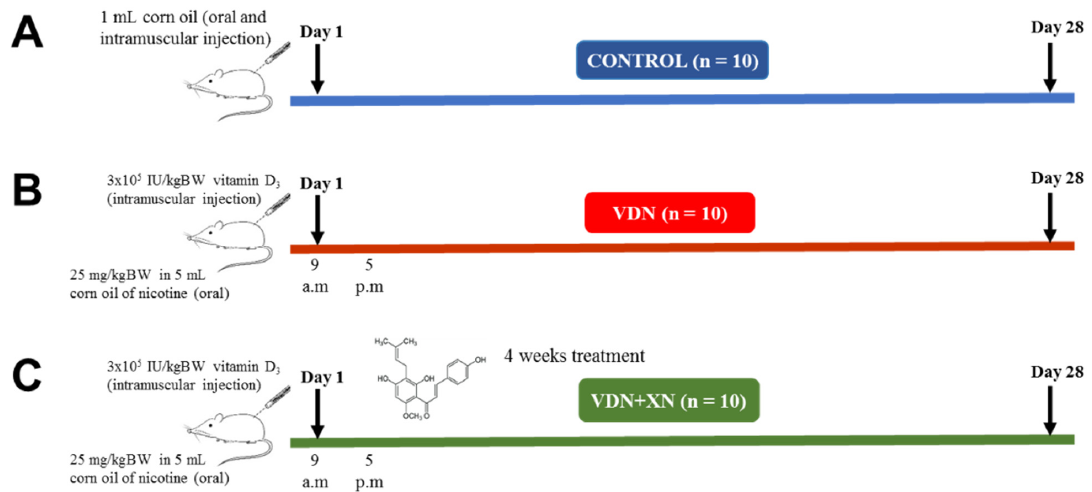
Figure 2. Outline of the experimental protocol. Sprague Dawley (SD) rats were randomly classified into three groups of 10 rats each. ( A ) Control group, ( B ) model (VDN) group, rats were intragastric administrated with 25 mg/kg BW in 5 mL corn oil of nicotine plus intramuscular injection of vitamin D 3 (3 × 10 5 IU/kg BW), and ( C ) treatment (VDN + XN) group, rats were orally treated with 20 mg/L in 0.1% ethanol for four weeks in drinking water.